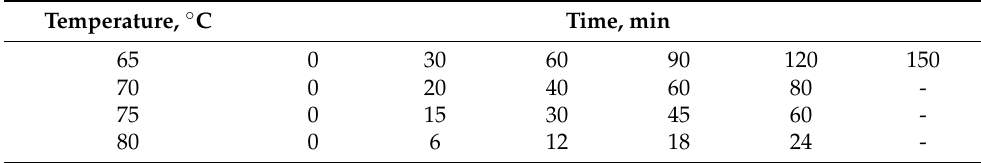
Table 1. Time-temperature combinations used to determine the thermal resistance of Salmonella spp. Temperature, ◦